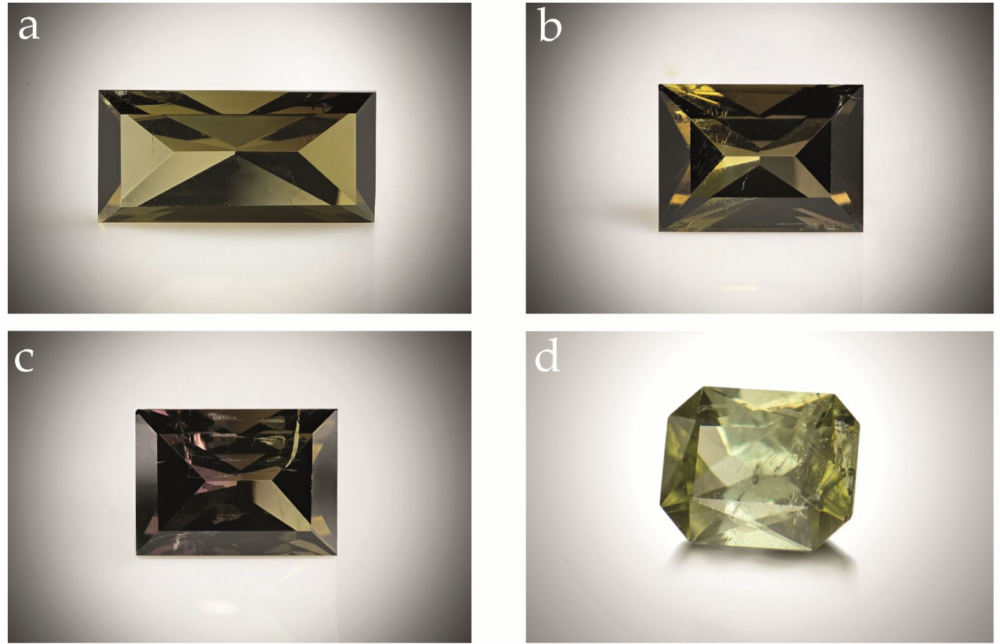
Figure 2. Cut tourmalines analysed in this study. ( a ) 3.97 × 8.31 × 2.61 mm; ( b ) 4.73 × 6.58 × 3.35 mm; ( c ) 4.61 × 6.36 × 3.26 mm, ( d ) 5.72 × 7.16 × 4.03 mm, corresponding to samples 13, 14, 15 and 16 described below in Table 1. Photos by M. Chinellato and F.